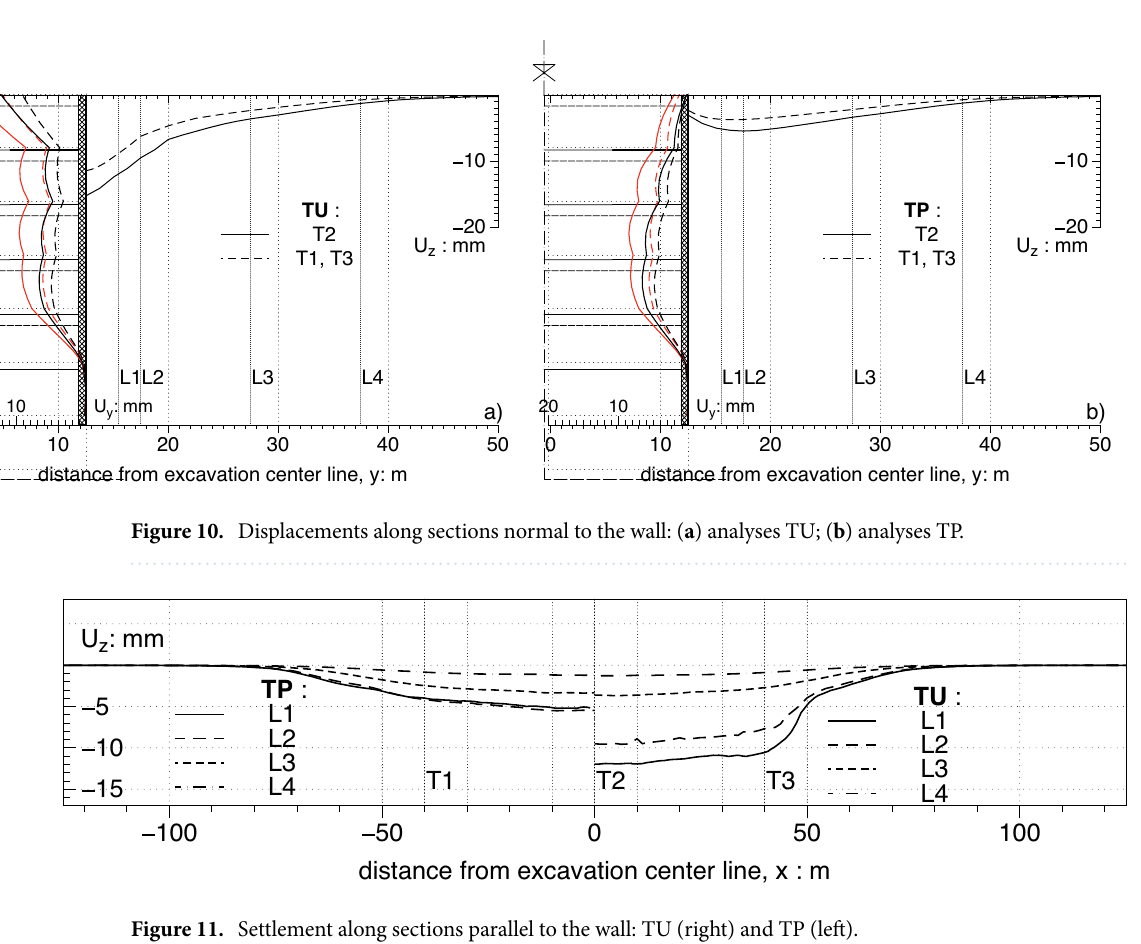
Figure 11. Settlement along sections parallel to the wall: TU (right) and TP